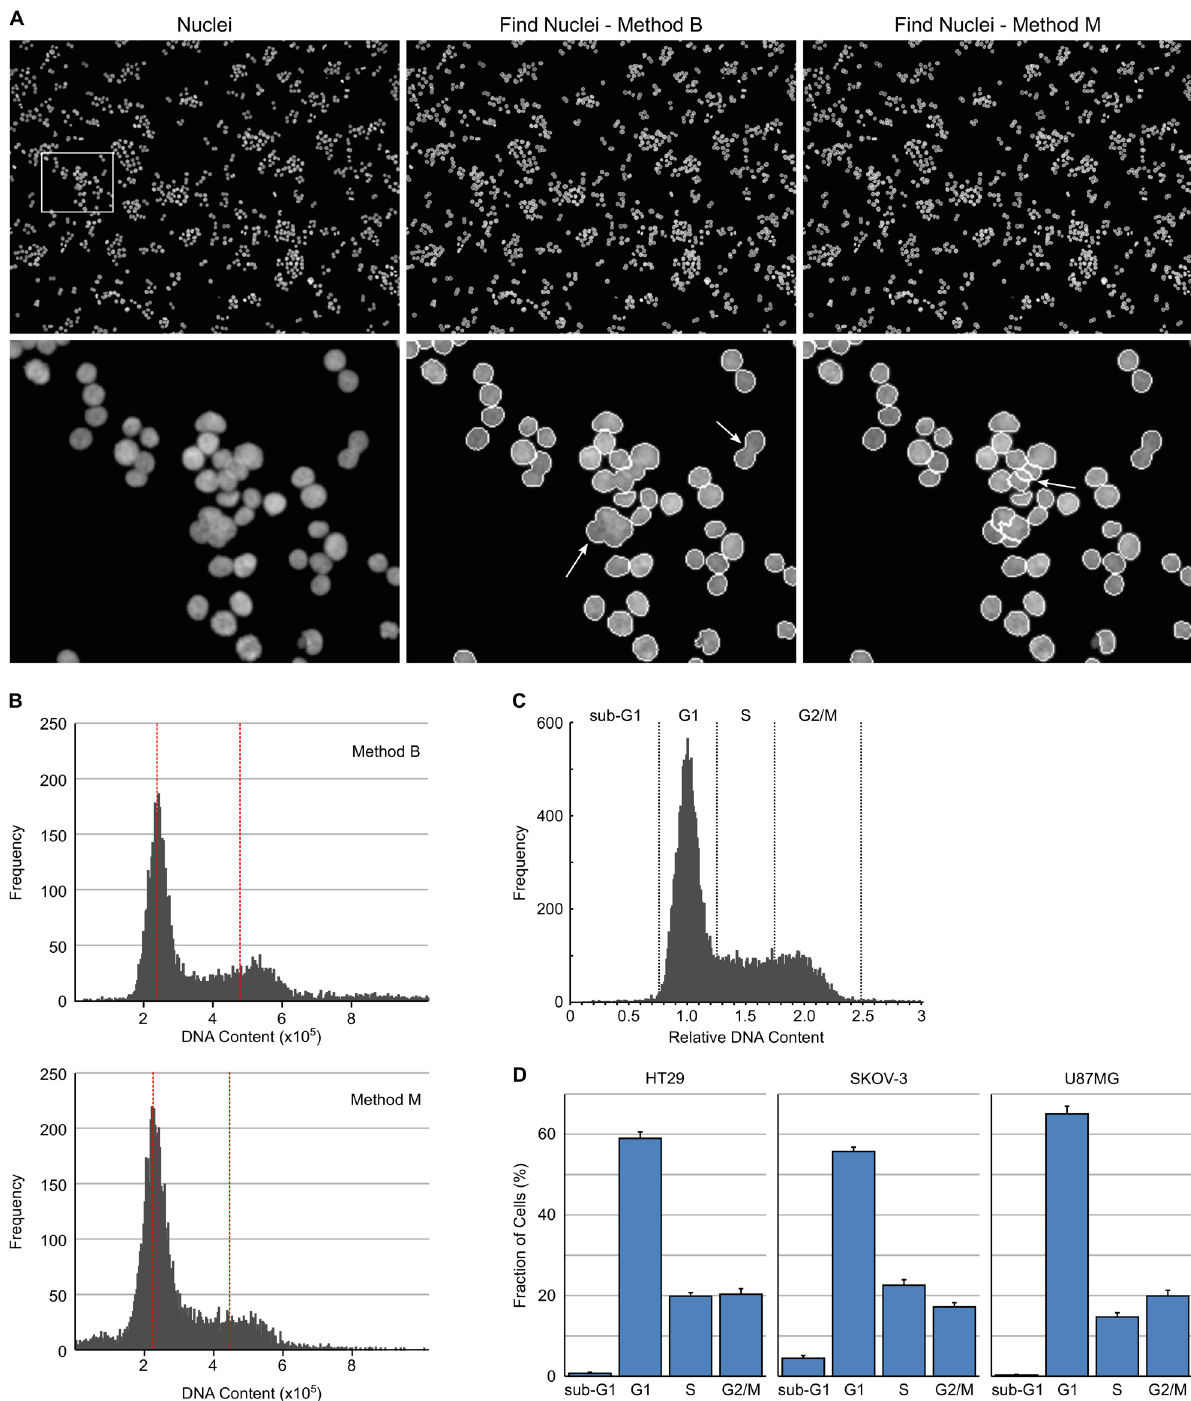
Fig 1. High-content cell cycle analysis based on DNA content. (A) Example images of HT29 cells with nuclei stained with Hoechst 33342 and then segmented with Harmony software using Find Nuclei Method B or Method M. Arrows indicate examples of incompletely segmented nuclei. (B) DNA content histograms of Hoechst 33342 stained HT29 cells, prior to application of the PhenoLOGIC algorithm, using Find Nuclei method B and M. Red dotted lines indicate the position of the G1 and G2 peak. (C) DNA content histograms obtained from HT29 cells showing gating to identify cell cycle distribution. (D) Cell cycle distribution for asynchronous HT29, SKOV-3 and U87MG cells determined from DNA content histograms. Values are the average of 8 technical replicates ± SD.